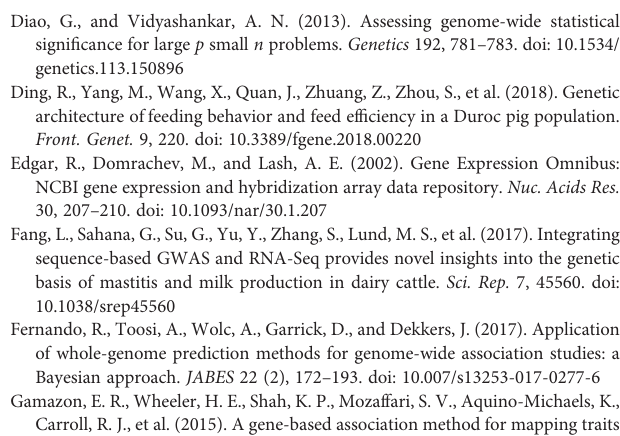
TABLE S1 | Sequencing statistics. TABLE S2 | Results from Gene Ontology (GO) analysis in each gene module. TABLE S3 | Signi fi cant SNP in association analysis and QTL and genes overlapped. TABLE S4 | Results of GWAS for SNP weight randomization. TABLE S5 | Associations identi fi ed in previous literature for signi fi cant